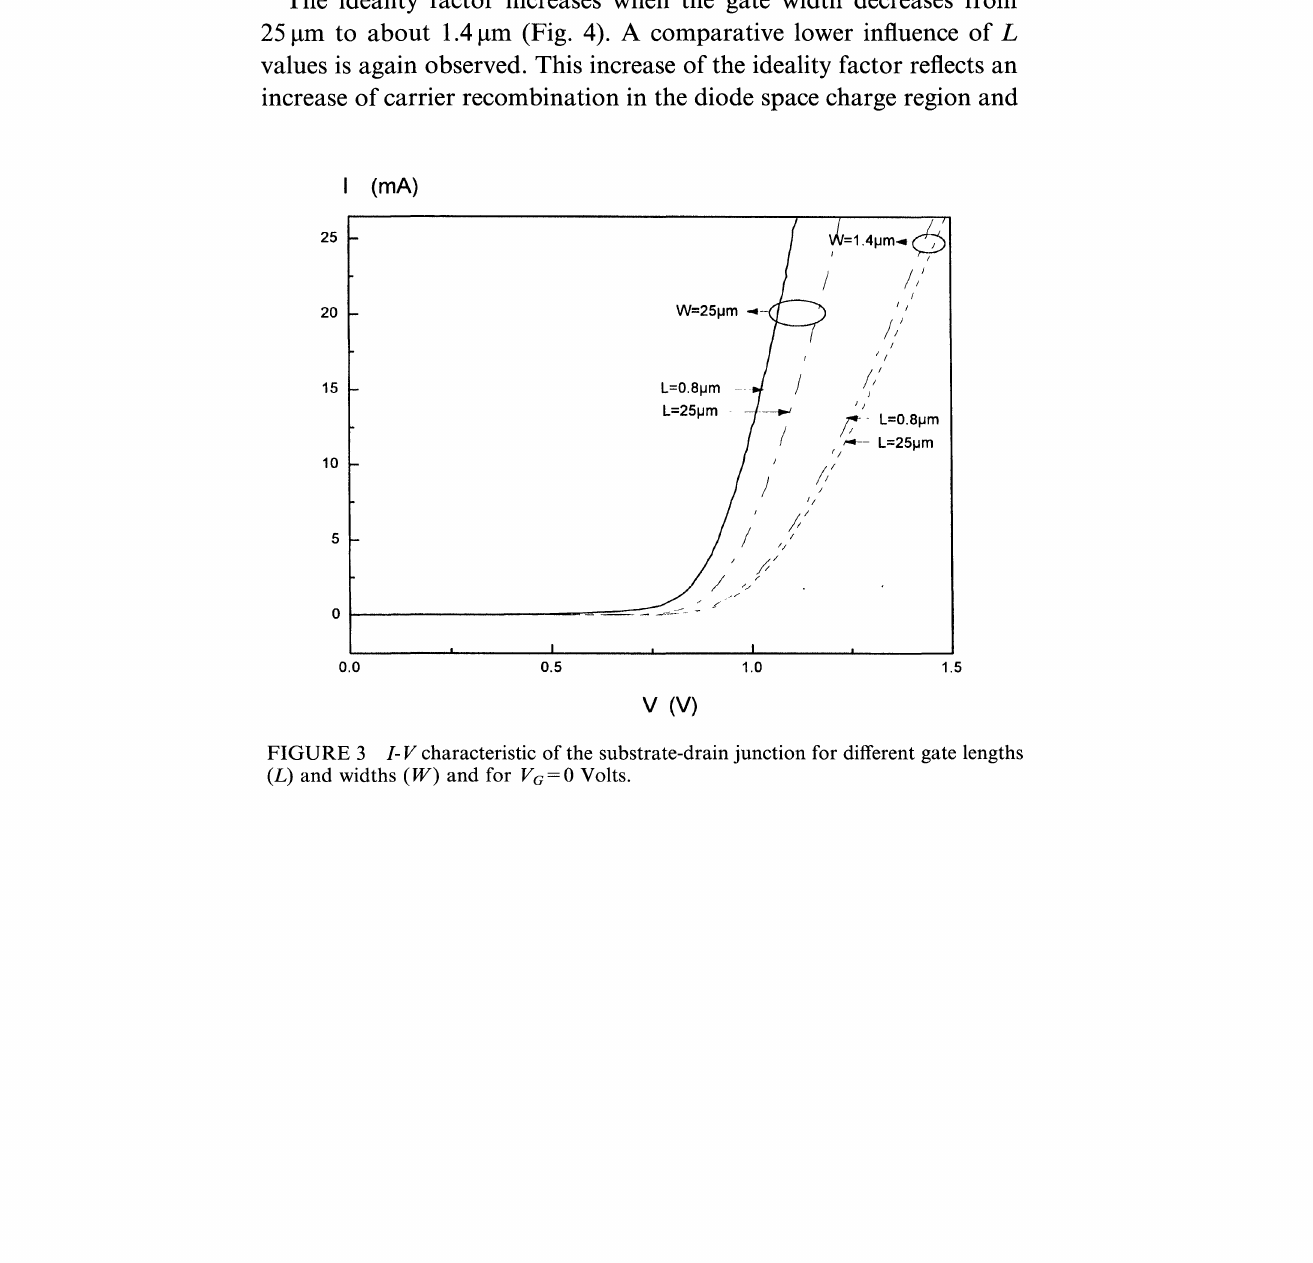
FIGURE 3 /-V characteristic of the substrate-drain junction for different gate lengths (L) and widths (W) and for V=0